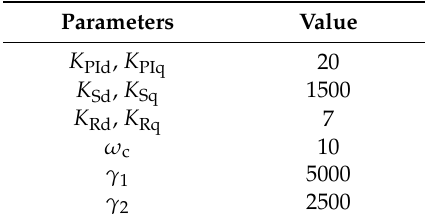
Table 1. Main parameters of the PIDR-SMCC-OIE controller.